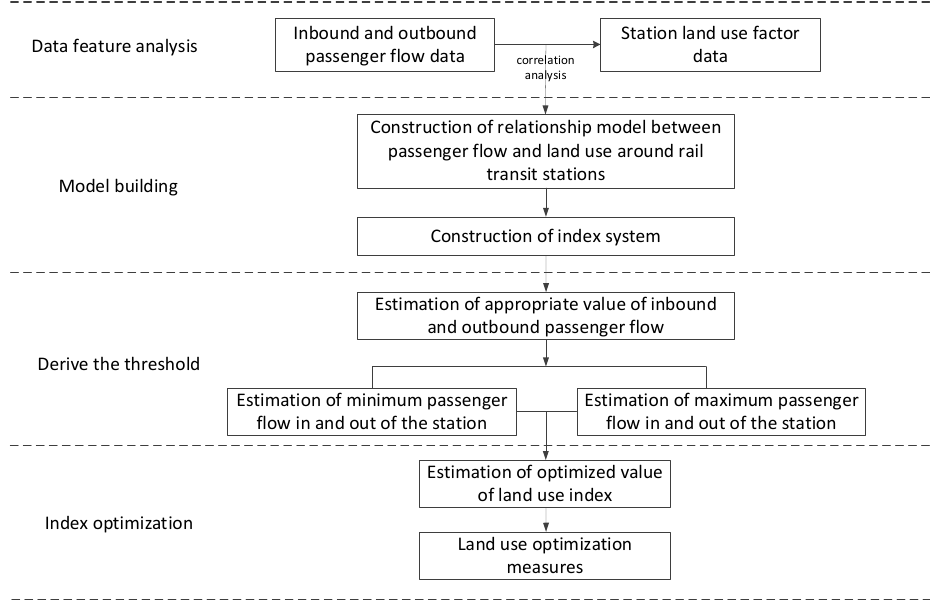
Figure 1. Research conceptual framework.